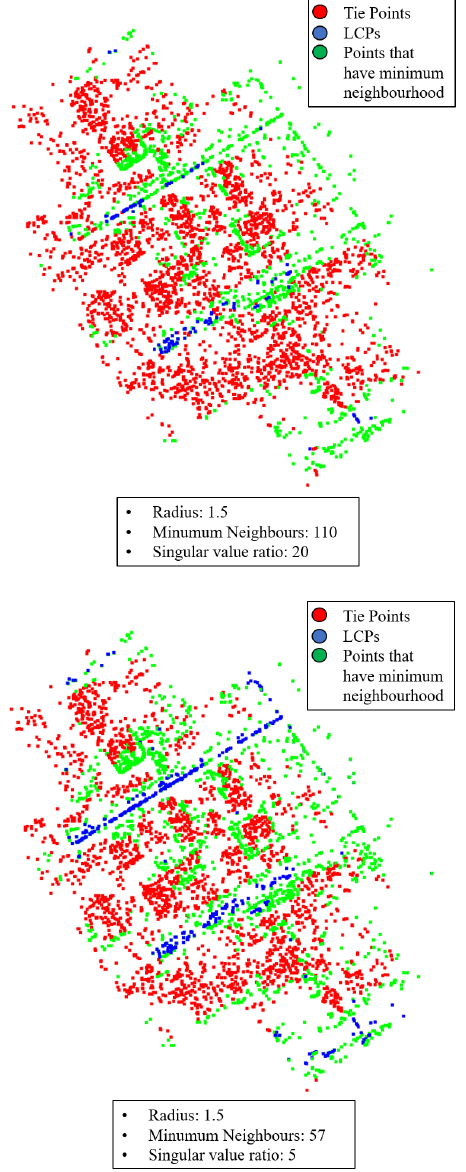
Figure 4. Displaying LCPs in two modes with different thresholds.